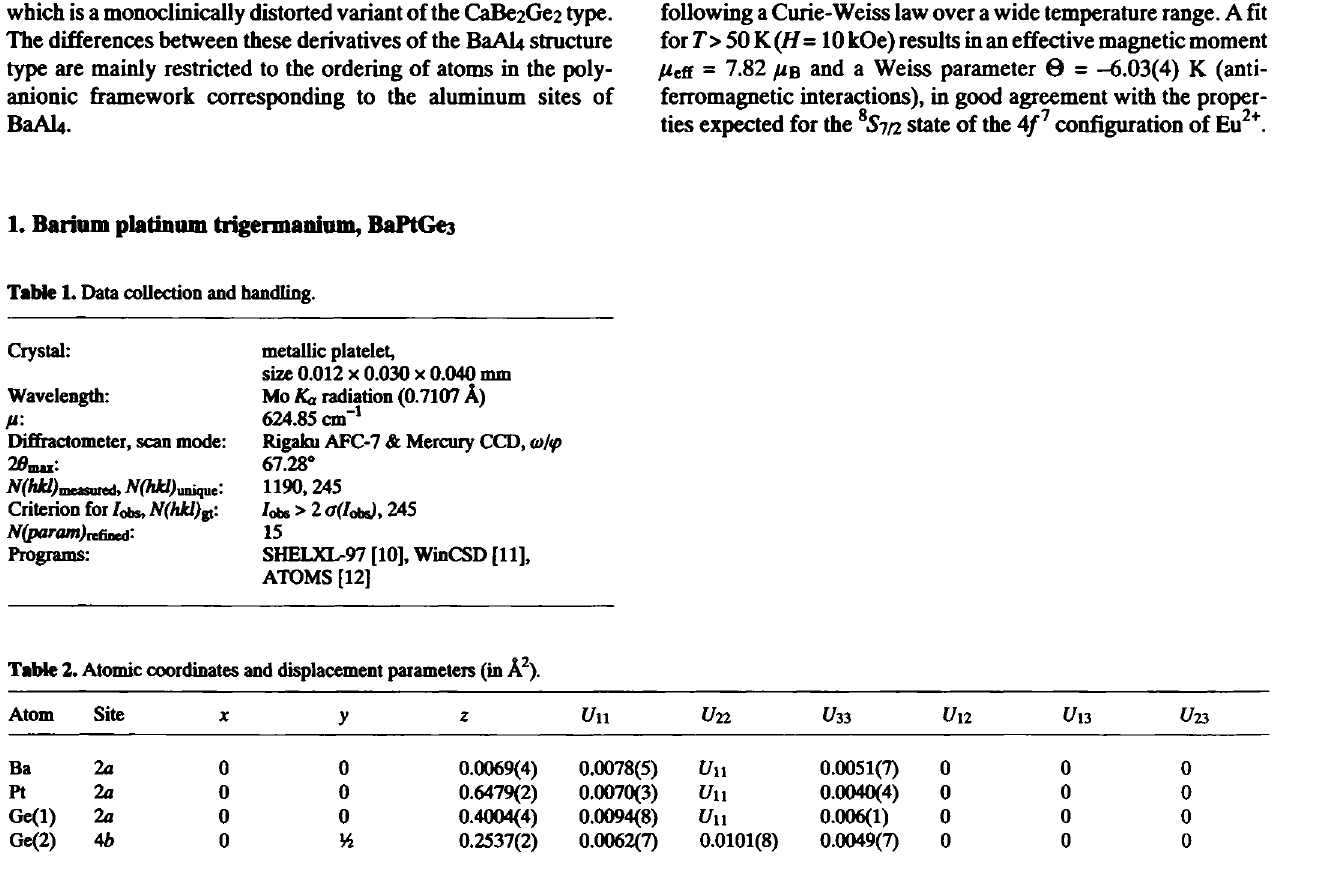
Table 3. Data collection and handling.